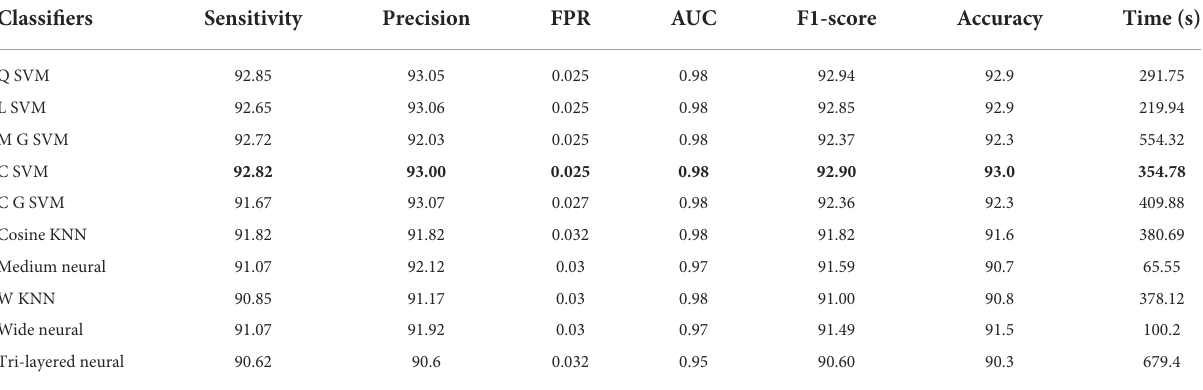
TABLE 3 Proposed features optimization results on COVID-19 Radiography